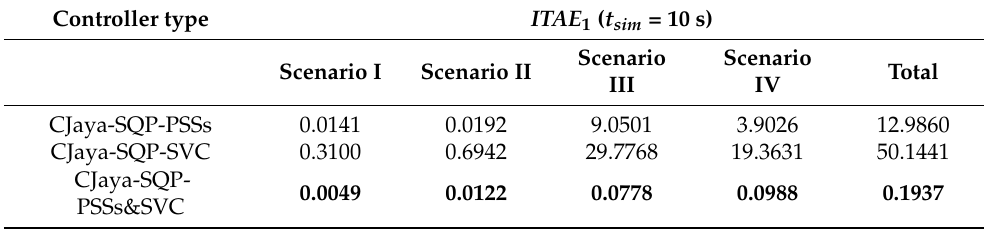
Table 15. Numerical results of ITAE 1 performance index for four suggested